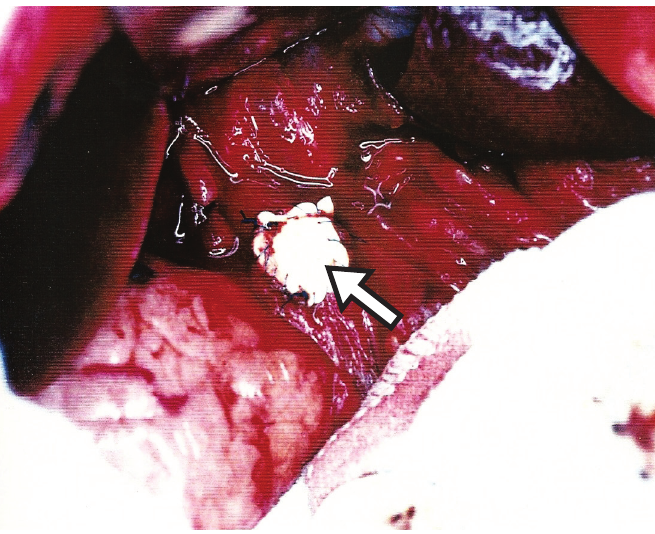
FIGURE 1 - A patch of ePTFE fixed to the duct wall of a Group 2 animal